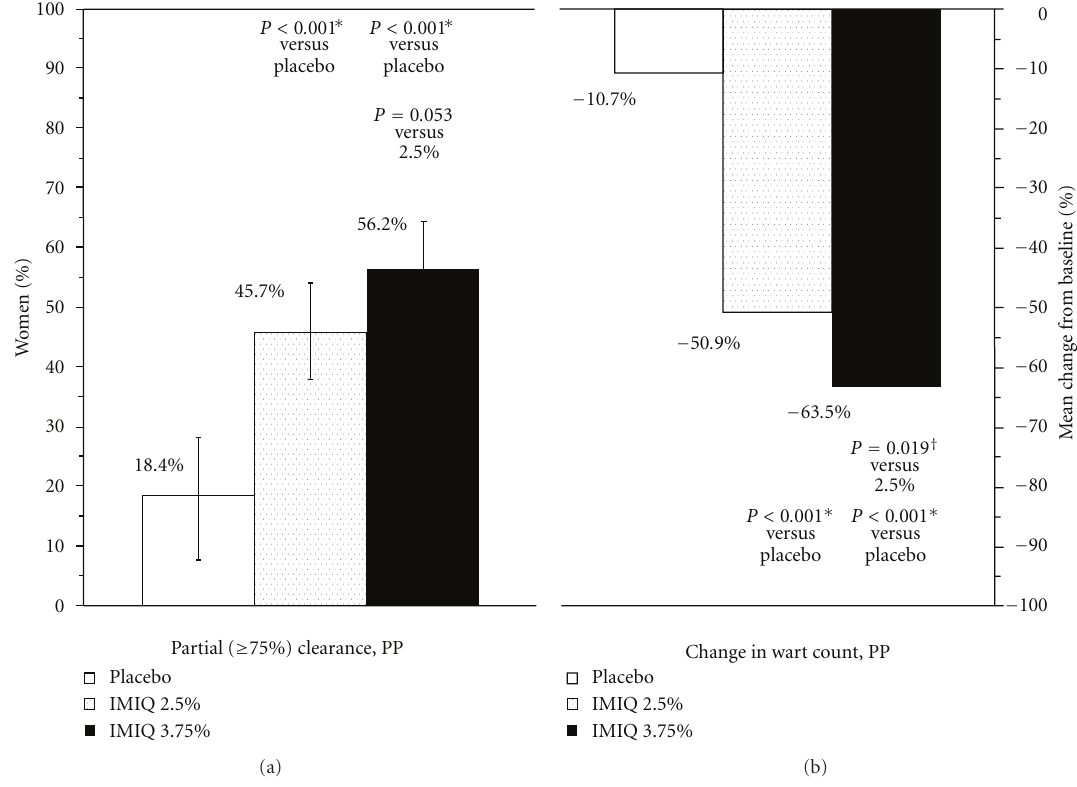
Figure 3: Partial clearance rates and change in wart count from baseline. White: placebo, stippled: imiquimod 2.5%, solid black: imiquimod 3.75%. (a) Partial ( ≥ 75% reduction in wart count compared to baseline) clearance rates, PP. P values from a Cochran-Mantel-Haenszel test, stratified by analysis site using two treatment groups at a time. ∗ indicates statistically significant for active versus placebo, and † for imiquimod 3.75% versus 2.5%, using Hochberg’s modified Bonferroni procedure. Bars indicate 95% confidence interval calculated using exact method. (b) Change in wart count compared with baseline, mean percent, PP. P values from an analysis of covariance test, controlling for baseline wart count and analysis site. ∗ indicates statistically significant for active versus placebo, and † for imiquimod 3.75% versus 2.5%, using Hochberg’s modified Bonferroni